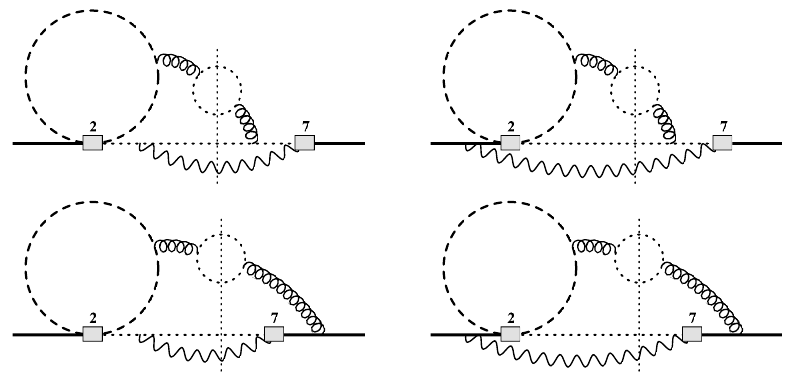
Figure 4 . Contributions to ^ G (2) the text.